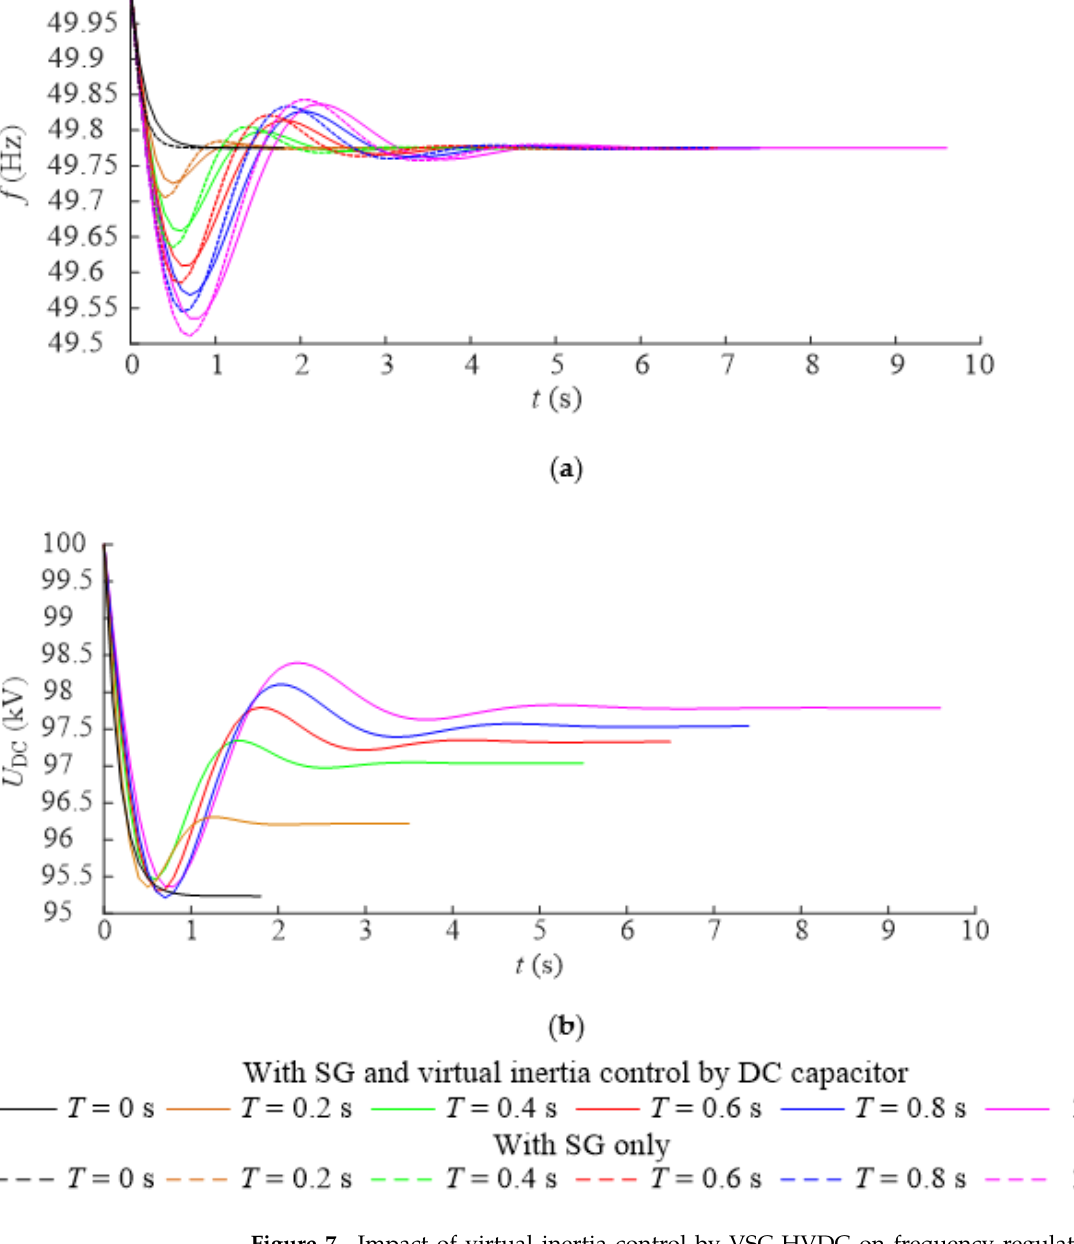
Figure 7. Impact of virtual inertia control by VSC-HVDC on frequency regulation: ( a ) System frequency; ( b ) DC voltage.